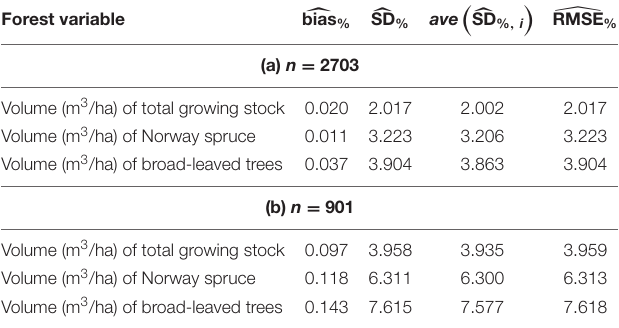
TABLE 4 | Monte Carlo results for the Horvitz and Thompson estimator (HT). Forest